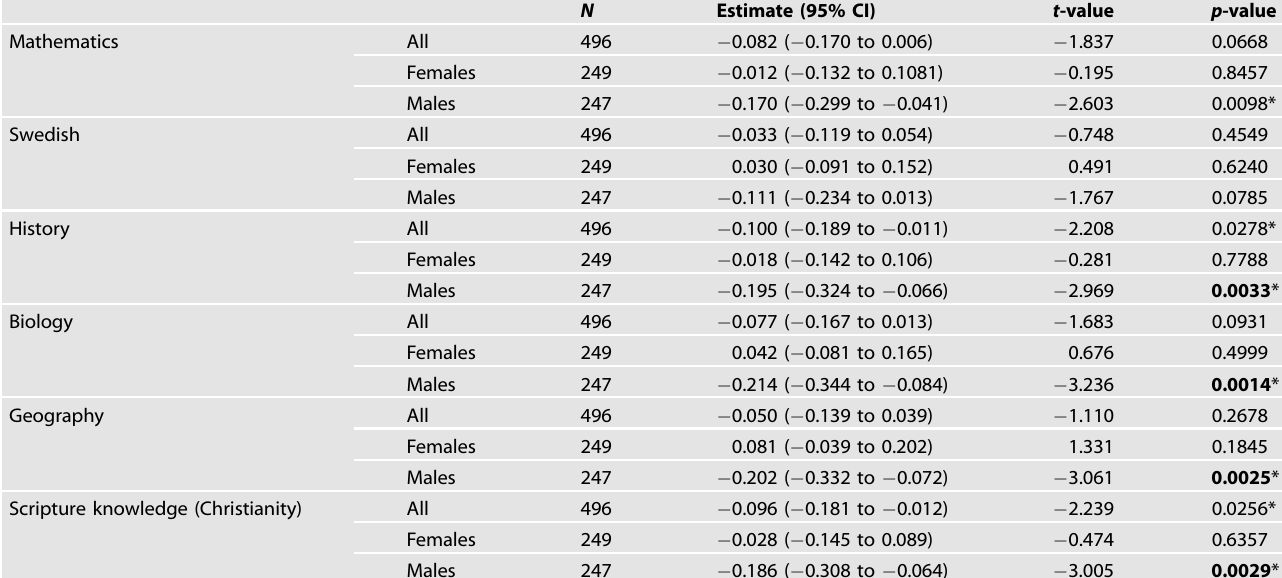
Table 2. Effect of schizophrenia PRS ( p -value threshold ≤ 1) on each school grade at age 12, separately for males and females as well as for all